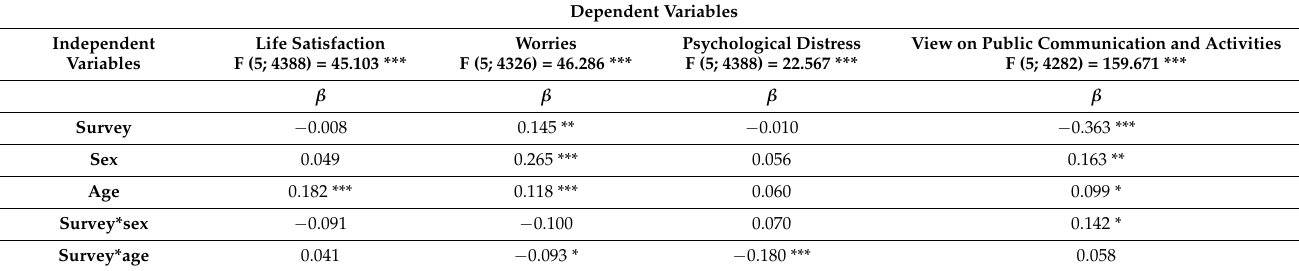
Table 3. Beta coefficients of the interaction effects of sex and age on mental health variables. Dependent